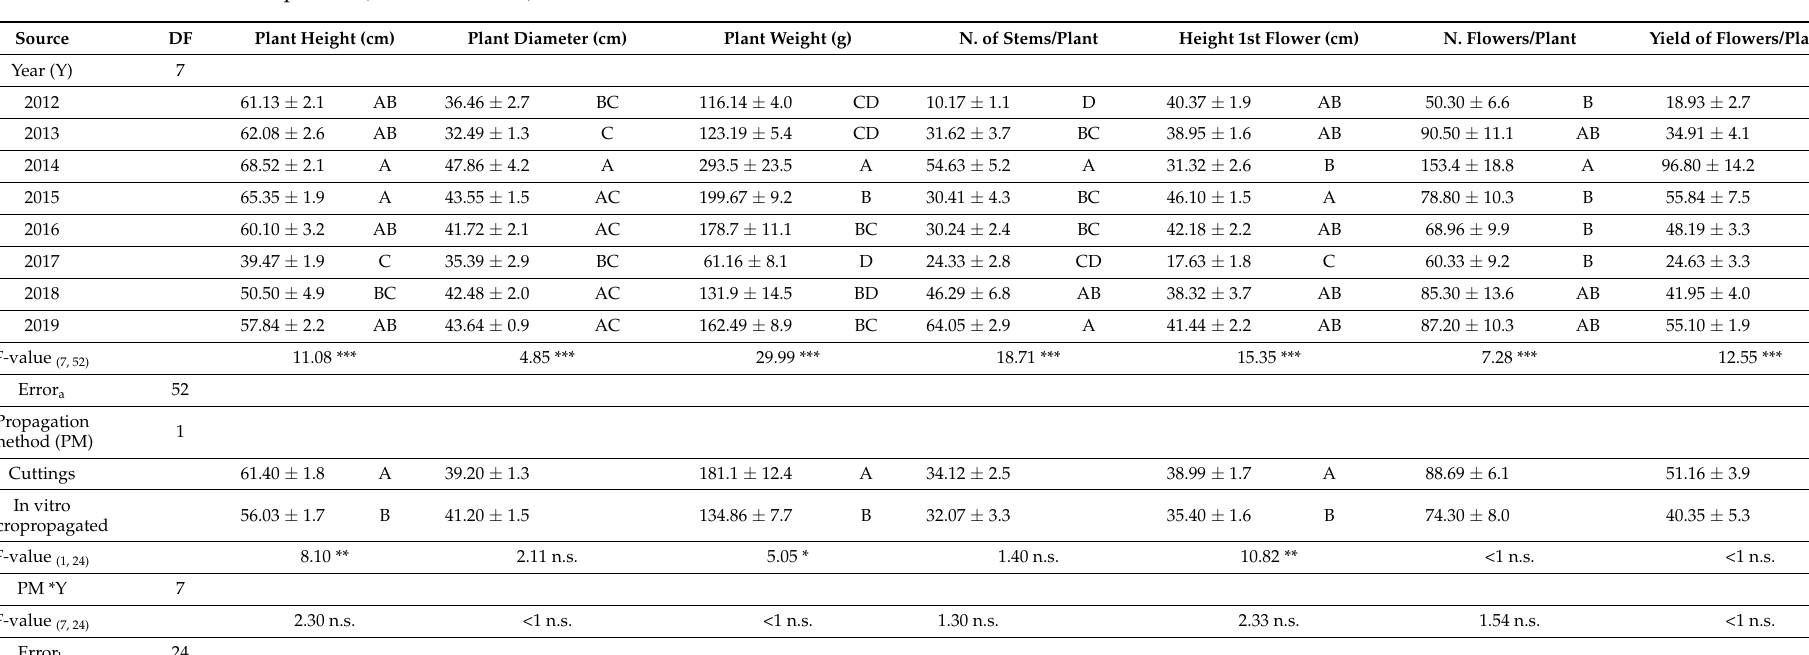
Table 1. Pyrethrum ( Chrysanthemum cinerariifolium ). Mean values ± SE and results of the ANOVA for the major morphological and yield characteristics recorded at Sparacia (Cammarata-AG) from 2012 to